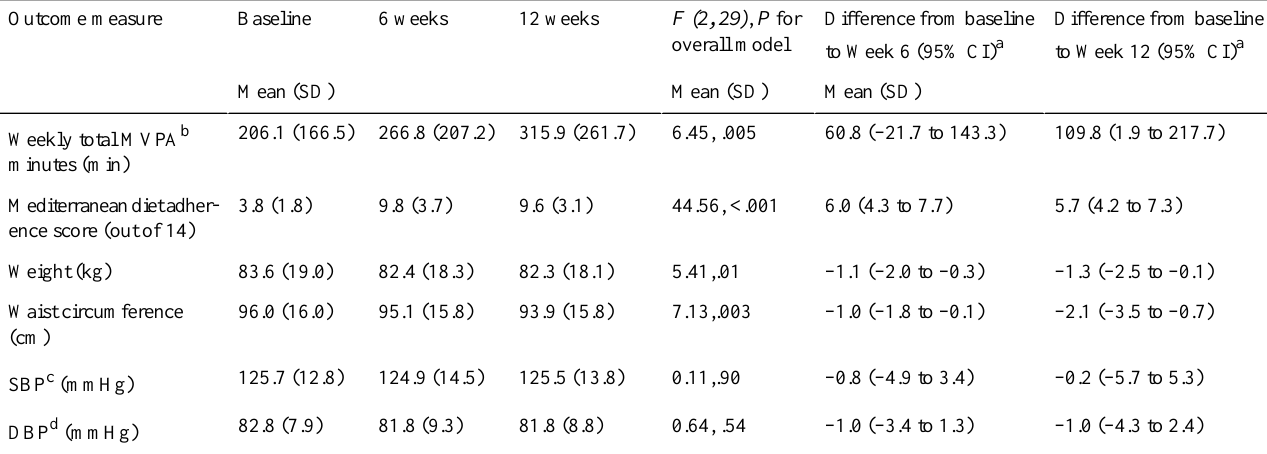
Table 2. Outcome measures at baseline, 6 weeks, and 12 weeks.